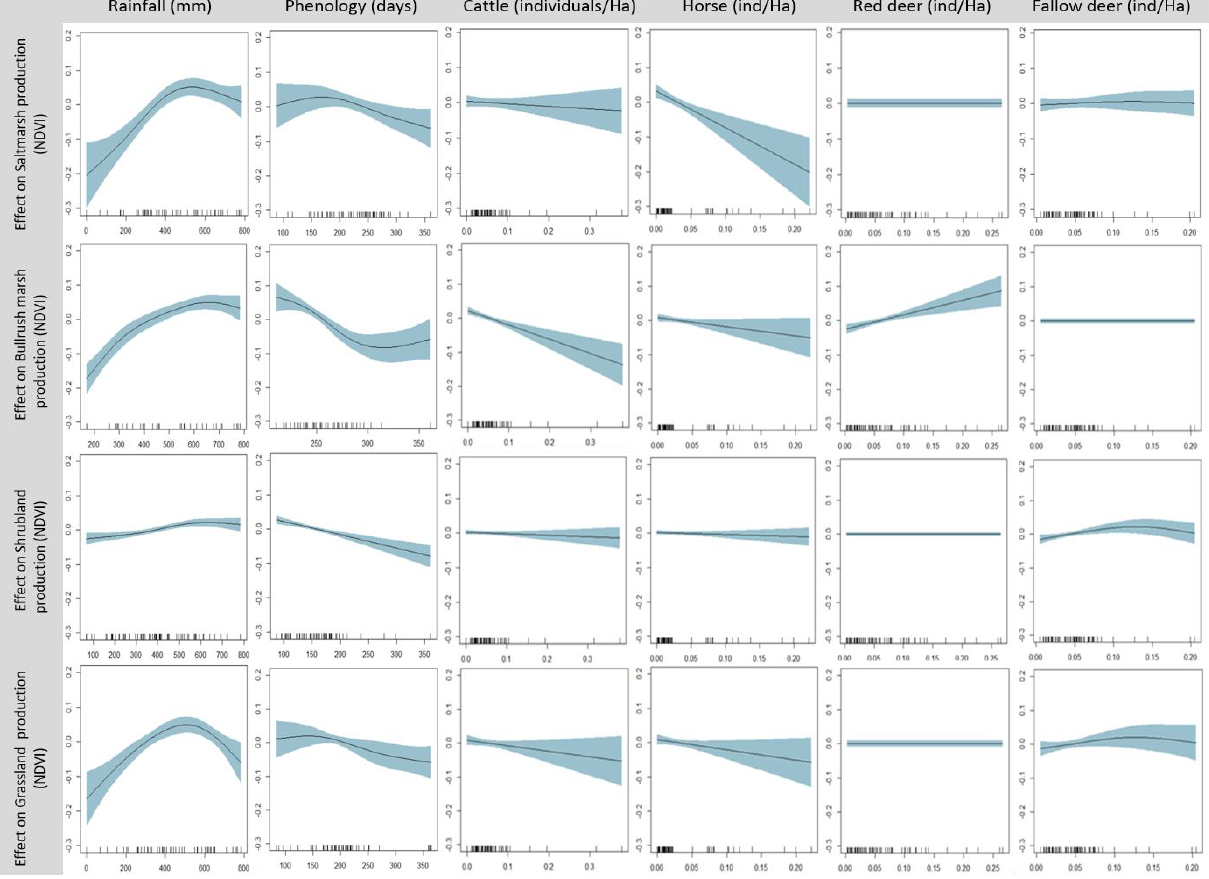
Figure 3. Predictor effects describing the effect of rainfall, phenology, and herbivore density on the production of the four different vegetation types. Grey-blue bands are confidence bands representing the 95% confident intervals. The small black lines at the bottom of each plot indicate x-values of individual observations in the dataset. The y-axis represents the effect of each variable on the production of each vegetation type.